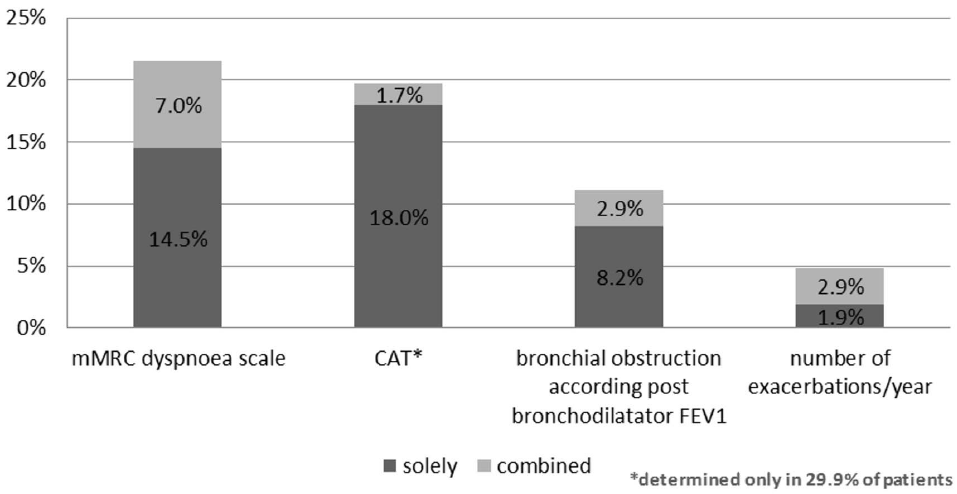
Figure 4. Contribution to the misclassification of an individual clinical component interpreted within the GOLD 2011 classification matrix. The percentage indicates relative frequency of misclassified cases attributable to a given clinical component. A sole effect is responsible for misclassified cases due to an obvious error in interpretation of one specific primary clinical parameter. The combined effect is responsible for misclassified cases due to an obvious error in interpreting both clinical criteria on the same axis (mMRC dyspnea scale and CAT respective bronchial obstruction and number of COPD exacerbations/year). Statistical probabilities were calculated of pair-wise contrasts as follows; mMRC dyspnea scale vs. CAT (p . 0.05), mMRC dyspnea scale vs. bronchial obstruction based on post bronchodilator FEV1 (p , 0.0001), mMRC dyspnea scale vs. number of exacerbations/year (p , 0.0001), CAT vs. bronchial obstruction (p , 0.0001), CAT vs. number of exacerbations/year (p , 0.0001), bronchial obstruction vs. number of exacerbations/year (p , 0.0001).